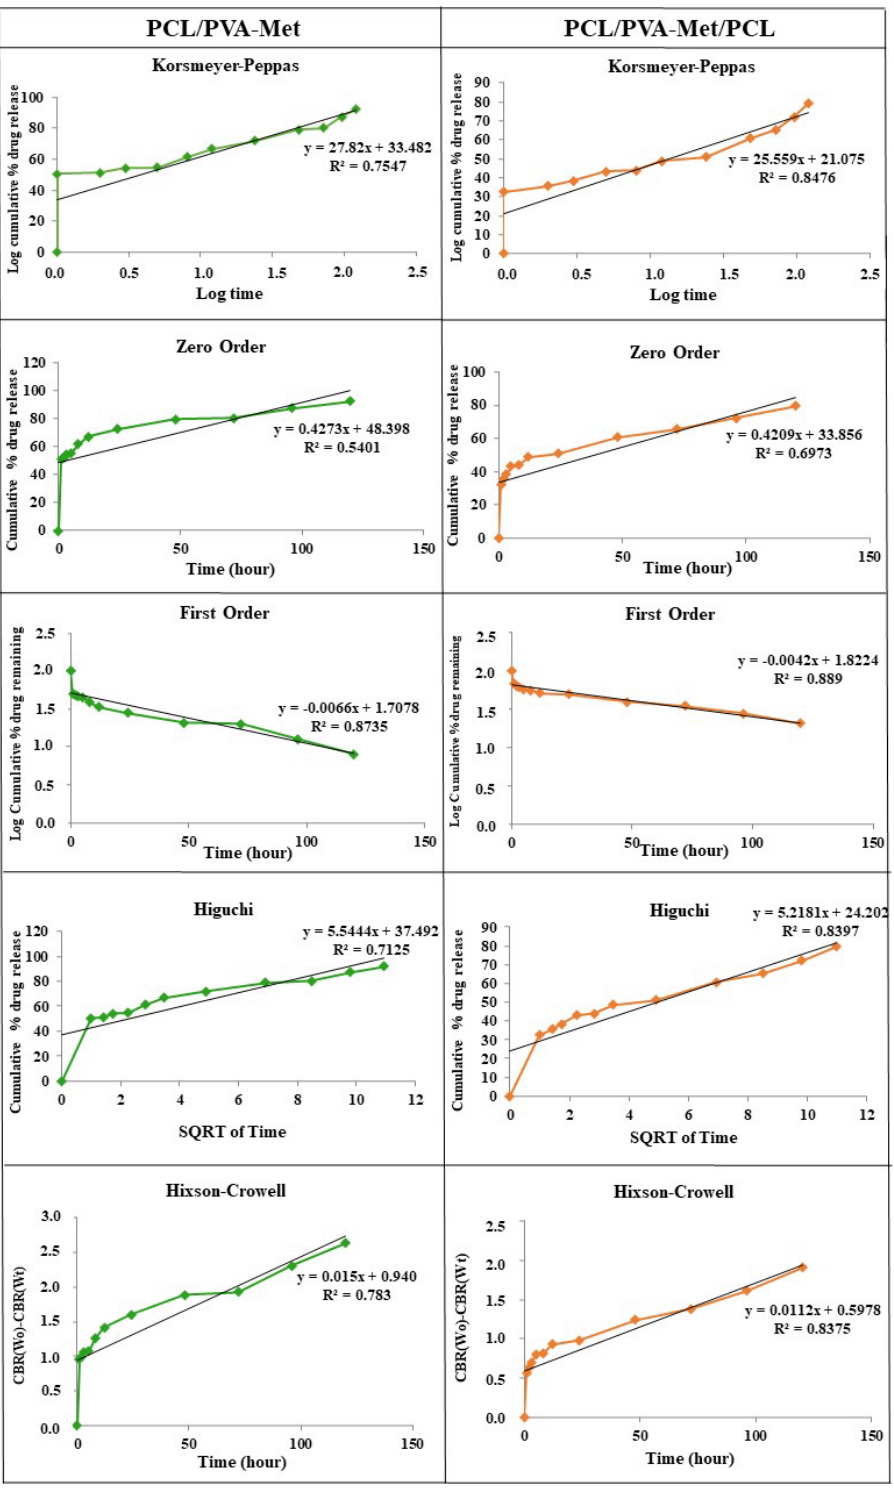
Figure 6. In vitro release kinetic models of the PCL/PVA-Met and PCL/PVA-Met/PCL